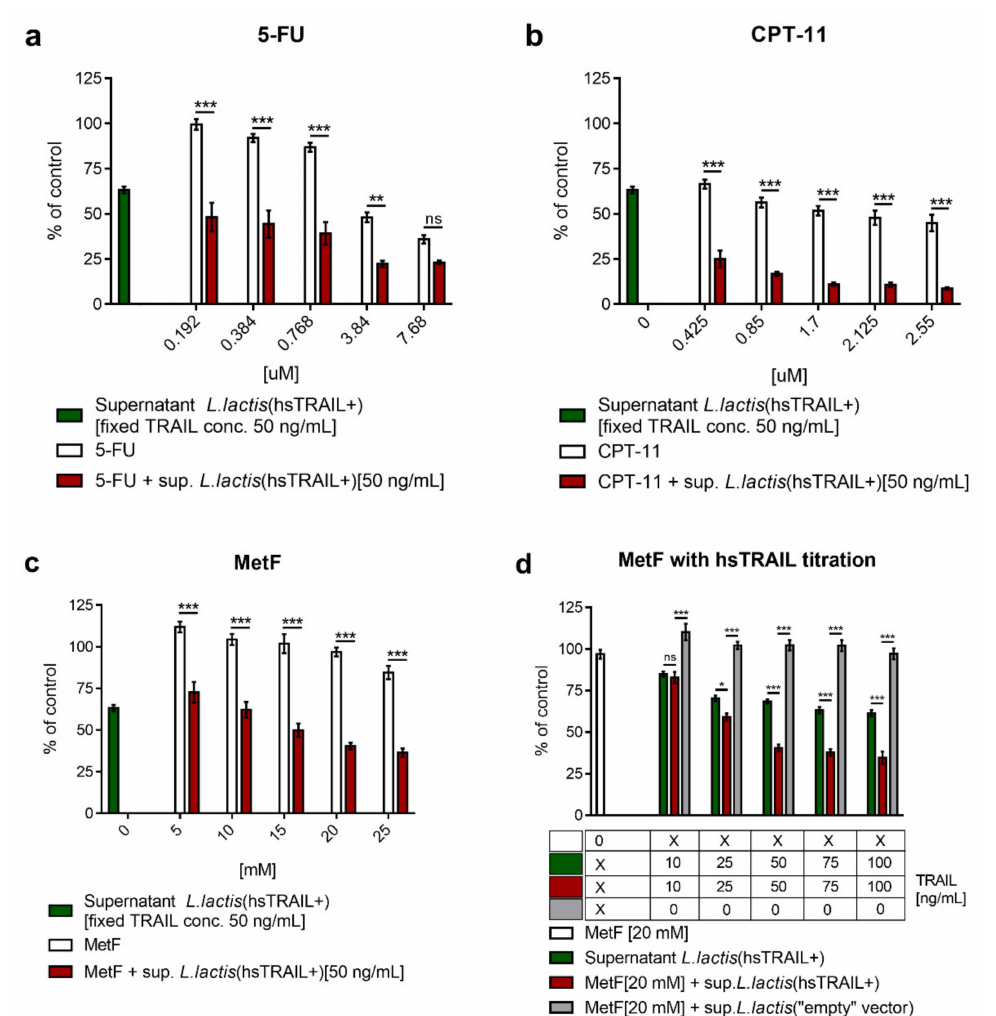
Figure 3. Anti-tumor activity of the selected drugs in combination with hsTRAIL against HCT116 cells in vitro. HCT116 cells were cultured for 48 h in the presence of 5-FU ( a ), CPT-11 ( b ) or MetF ( c ), in monotherapies or in combination with hsTRAIL (50 ng/mL, in a form of supernatant from the broth culture of L. lactis (hsTRAIL+)); ( d ) HCT116 were cultured for 48 h in the presence of fixed concentration of MetF (20 mM) and different concentrations of hsTRAIL, in a form of supernatant from the broth culture of L. lactis (hsTRAIL+). As negative control, supernatant from L. lactis (“empty” vector) bacteria was used in the corresponding volumes. Viability of HCT116 cells was assessed by MTS assay. Results are shown as % of viable cells incubated in an appropriate standard culture medium ( y -axis). x axis—drug concentrations. The bars indicate the mean value ± SEM of three independent experiments, each performed in triplicates ( a , b ) or four independent experiments ( d ). Statistical significance was performed using two-way ANOVA test, with Tukey’s multiple comparisons post-hoc test. * p < 0.05, ** p < 0.01, *** p <